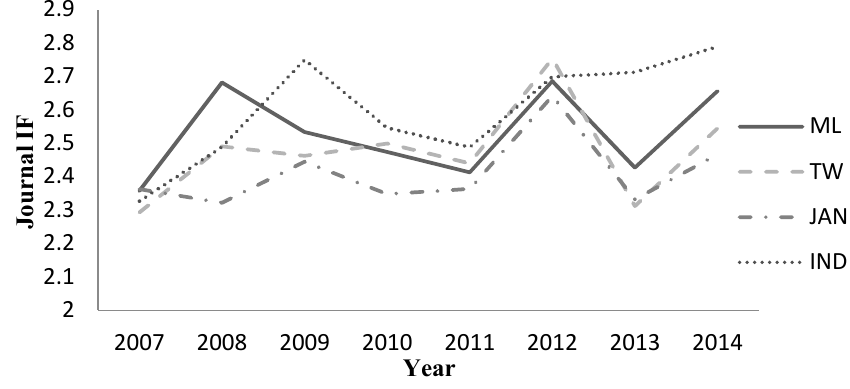
Figure 2. The trend in average Impact Factor (IF) of articles in the field of “health care sciences and services” published by researchers from Mainland China (ML), Japan (JPN), Taiwan (TW), and India (IND) (2007–2014).